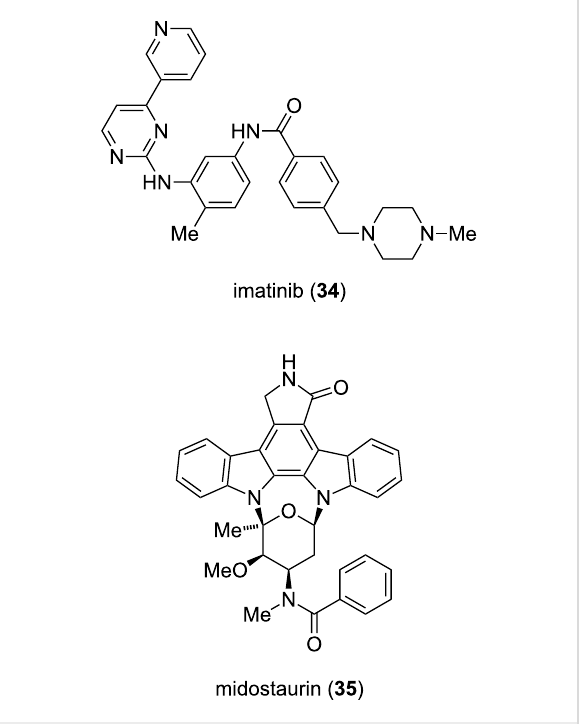
Figure 4: Structure of imatinib ( 34 ) and midostaurin ( 35 ).